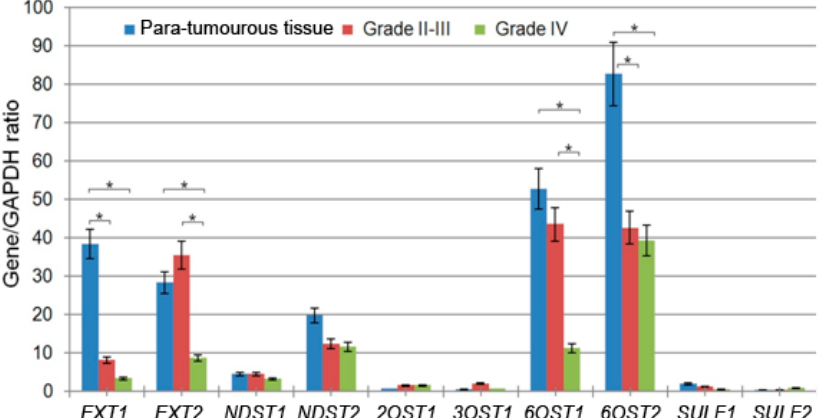
Figure 2. Expression of HS biosynthesis-related genes in human gliomas of different grades. The intensity of the amplified DNA fragments was normalised to that of GAPDH . The graphs show the mean expression levels from triplicate experiments ± SD (Origin 8.5; OriginLab Corporation, Northampton, USA); * p < 0.01.